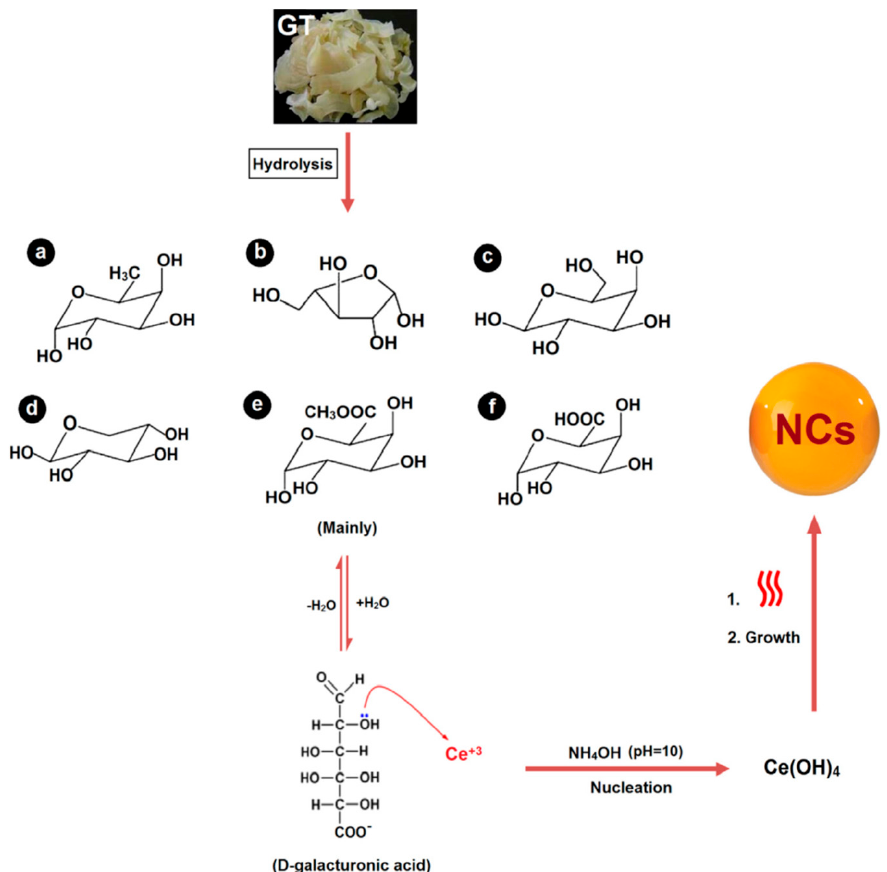
Figure 3. Schematic representation showing the usability of GT in the green synthesis of nanoceria particles (NCs): ( a ) α -L-fucose, ( b ) L-arabinose, ( c ) β -D-galactose, ( d ) β -D-xylose, ( e ) α -D-Galacturonic acid methyl ester, and ( f ) α -D-galacturonic. Reproduced from ref [54], Copyright 2014, Elsevier.